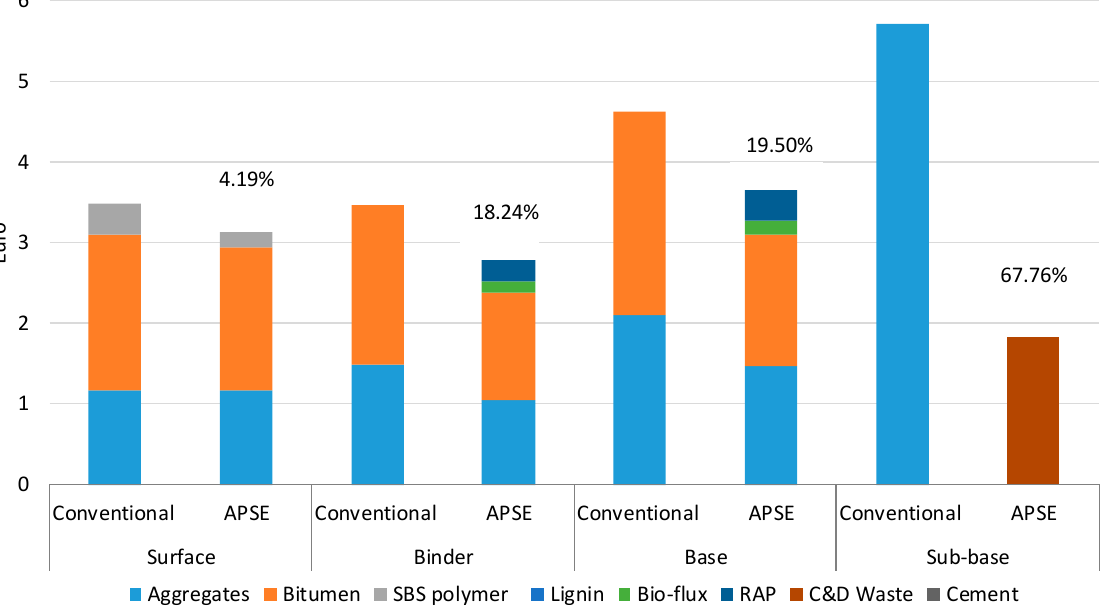
Figure 8. Materials costs of flexible pavement in Poland, total costs of 1 m² of conventional and apse road pavement.